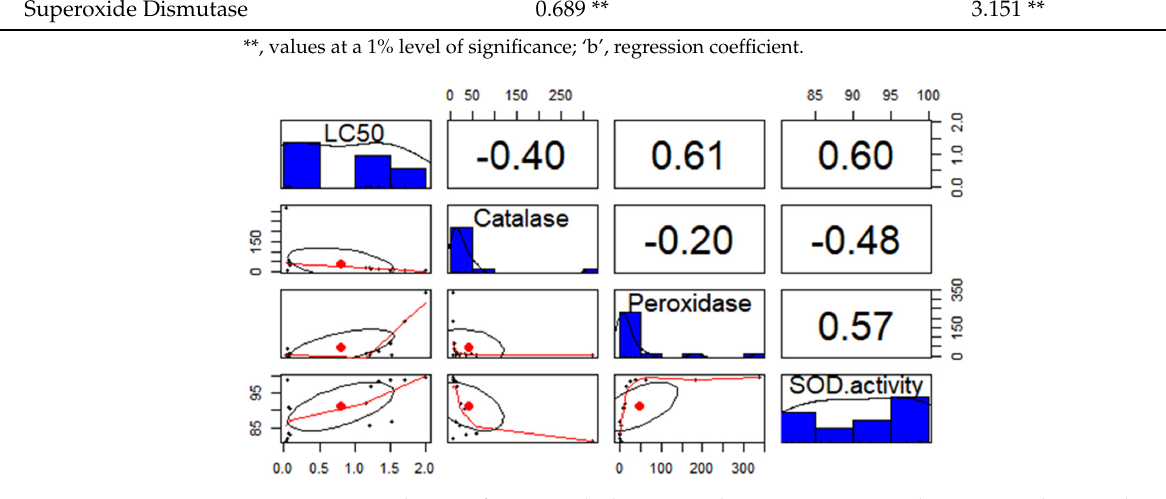
LC 50 ), and two factors, viz., PC1 and PC2, with the highest Eigenvalues of 2.45 and 0.82, respectively, were chosen, as they accounted 61.37% and 20.42% of variance, respectively (Supplementary Materials Table S1). The biplot graph (Figure 3a) shows that peroxidase was positively related with PC1 and PC2, whereas SOD was positively related to PC2 and negatively related to PC1. The influence of LC 50 was significantly high on peroxidase and SOD activities, whereas it had a very strong negative correlation with catalase (Figure 3b). The biplot depicts that the populations showing high resistance to phosphine such as Safidon (LC 50 = 1.991 mg/L), Patiala (LC 50 = 1.708 mg/L), and Karnal (LC 50 = 1.498 mg/L) were distributed together in the positive region of the biplot, in correspondence with pe- roxidase and SOD activity, and the populations from northeastern India and the lab sus- ceptible population (Pusa) (LC 50 = 0.024 mg/L) were grouped together.